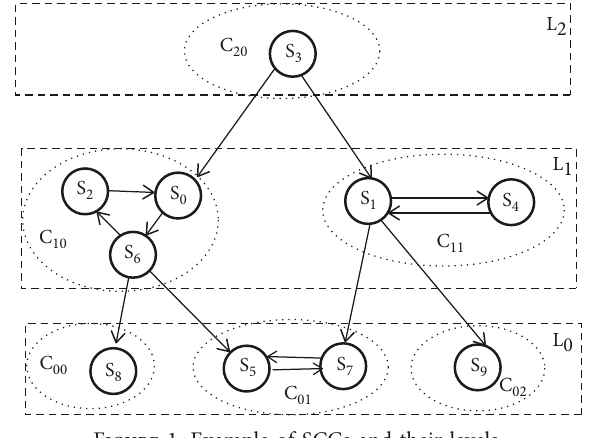
Figure 1: Example of SCCs and their